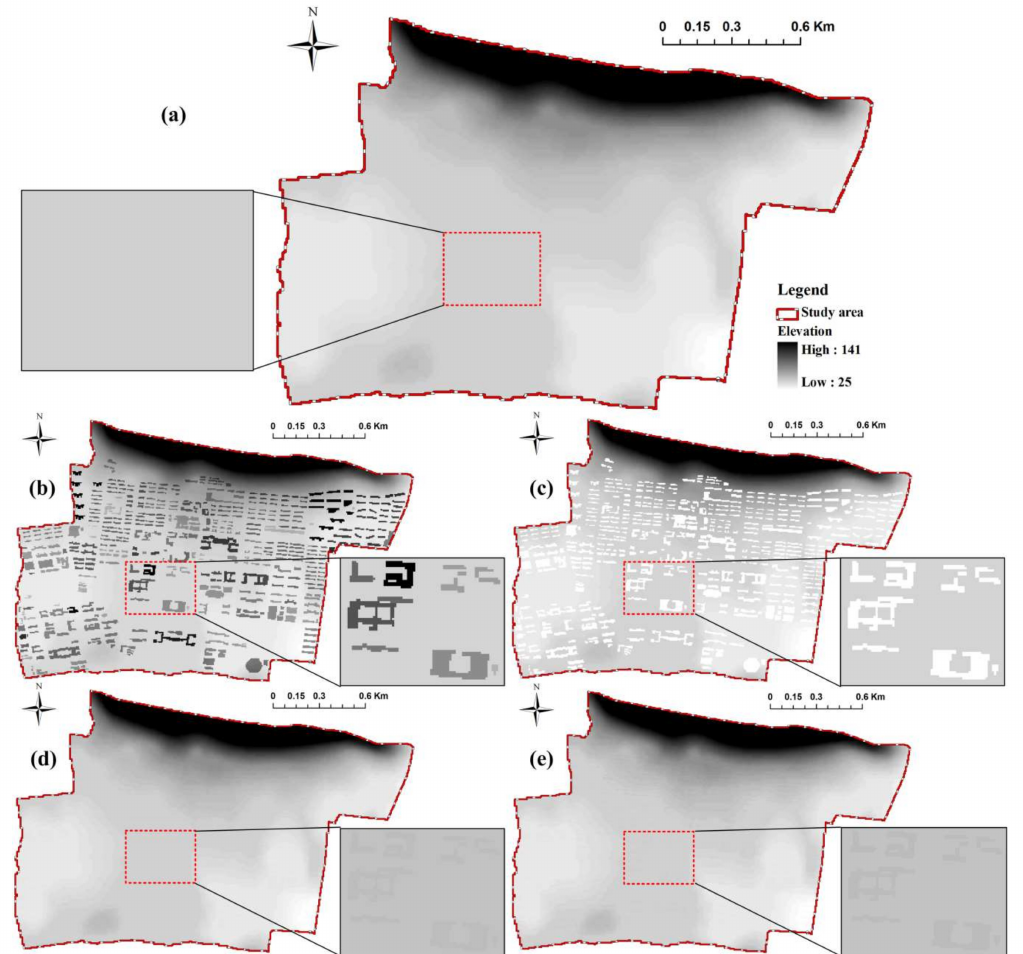
Figure 5. The bare-earth DEM of the study area ( a ), and the topographic processing results for each building treatment method: ( b ) the BB method; ( c ) the BH method; ( d ) the IBTA0.4 method; and ( e ) the IBTA0.6